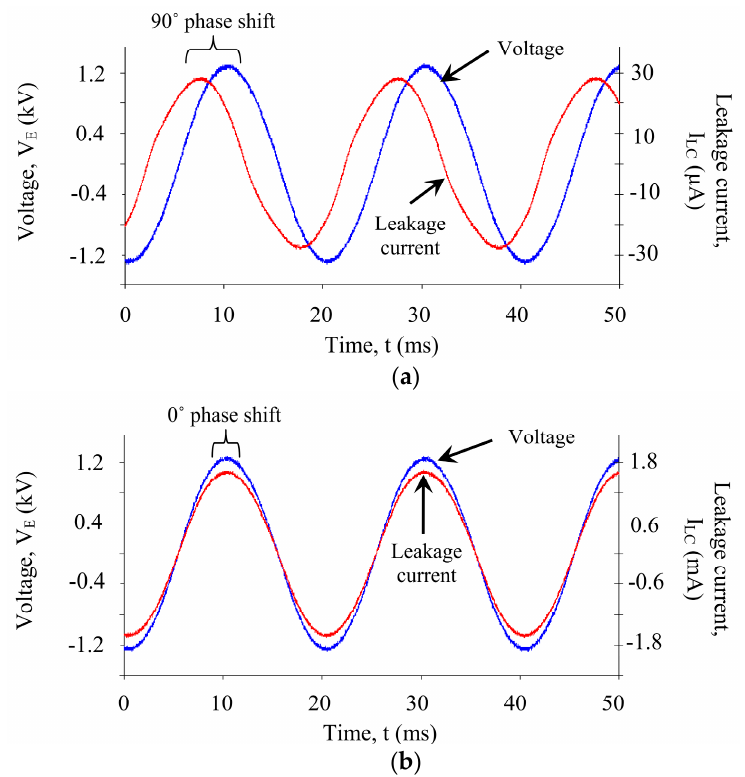
Figure 6. Voltage and leakage current of an insulator under test: ( a ) clean condition; ( b ) Polluted condition.